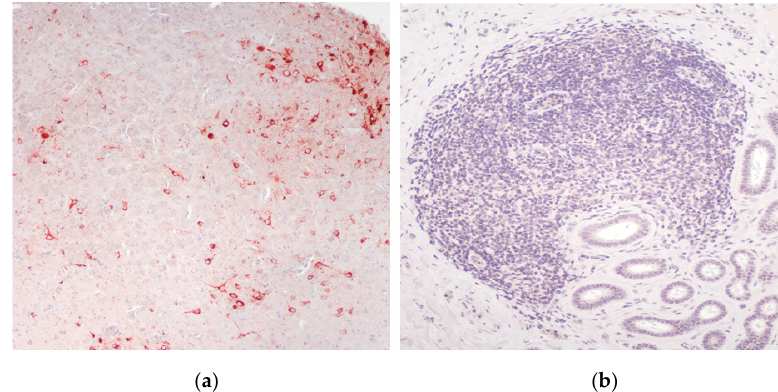
Figure 11. Immunohistochemical detection of WNV KUN NS1, using mAb 4G4, in tissues from experimentally infected animals. ( a ) Brain from mouse experimentally challenged with the NSW2011 isolate of WNV KUN [16] showing virus protein-positive neurons throughout the cerebrum (red cells). ( b ) Lymphoid aggregate in the tongue of a hatchling crocodile 21 dpi with WNV KUN . No virus antigen-positive cells are apparent in either the lymphoid aggregate, sublingual glands, endothelial cells or the interstitial tissue fibrocytes.